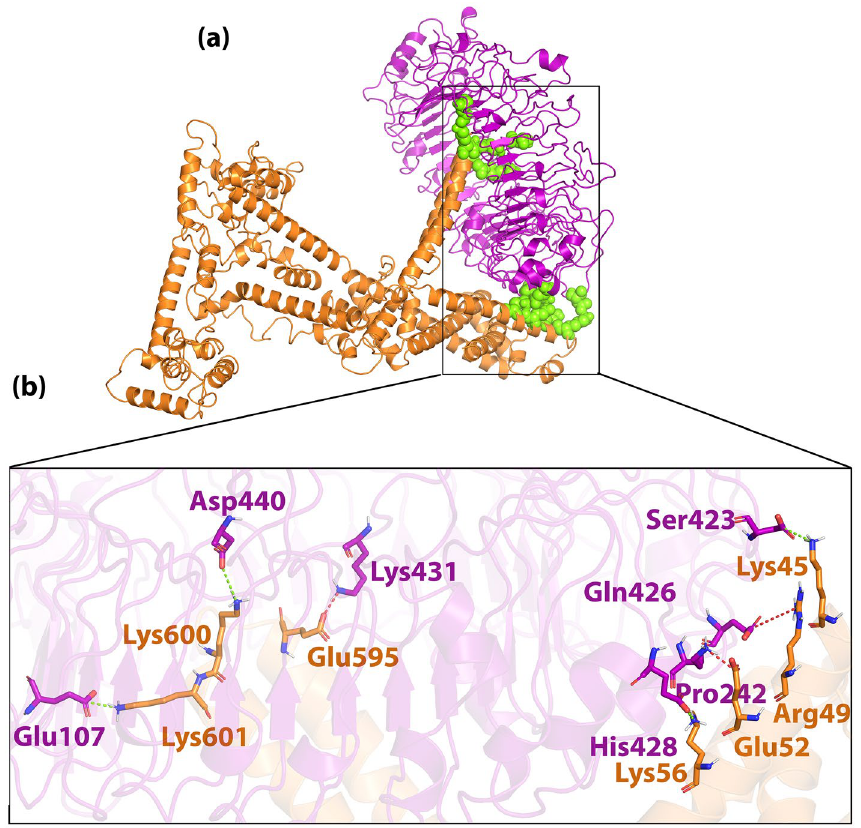
Figure 8. ( a ) Visualization of docking HADDOCK results for H7N9vac-TLR8 complex and ( b ) magnified residues interaction of H7N9vac-TLR8 complex. H7N9v structure is shown as the carton and sticks in copper color. TLR8 structure is shown as the carton and sticks in purple color. Hydrogen bonds are shown as the green dashed line and salt bridges are shown as the red dashed